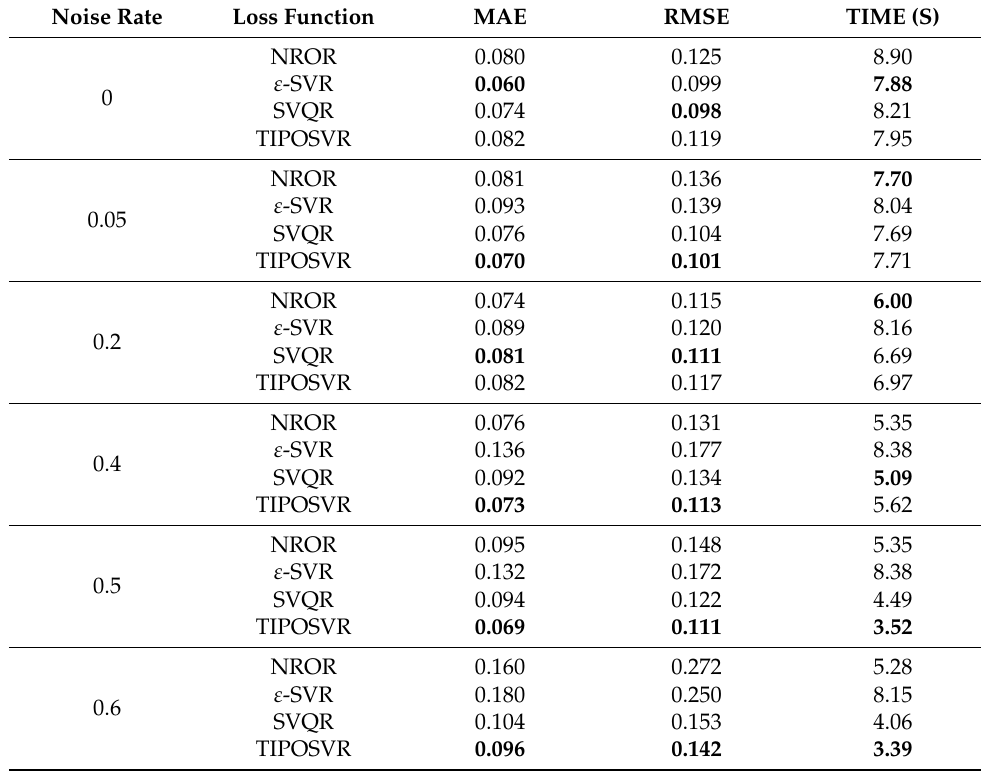
Table 4. Operation results of algorithms under the influence of noise typeII for synthetic